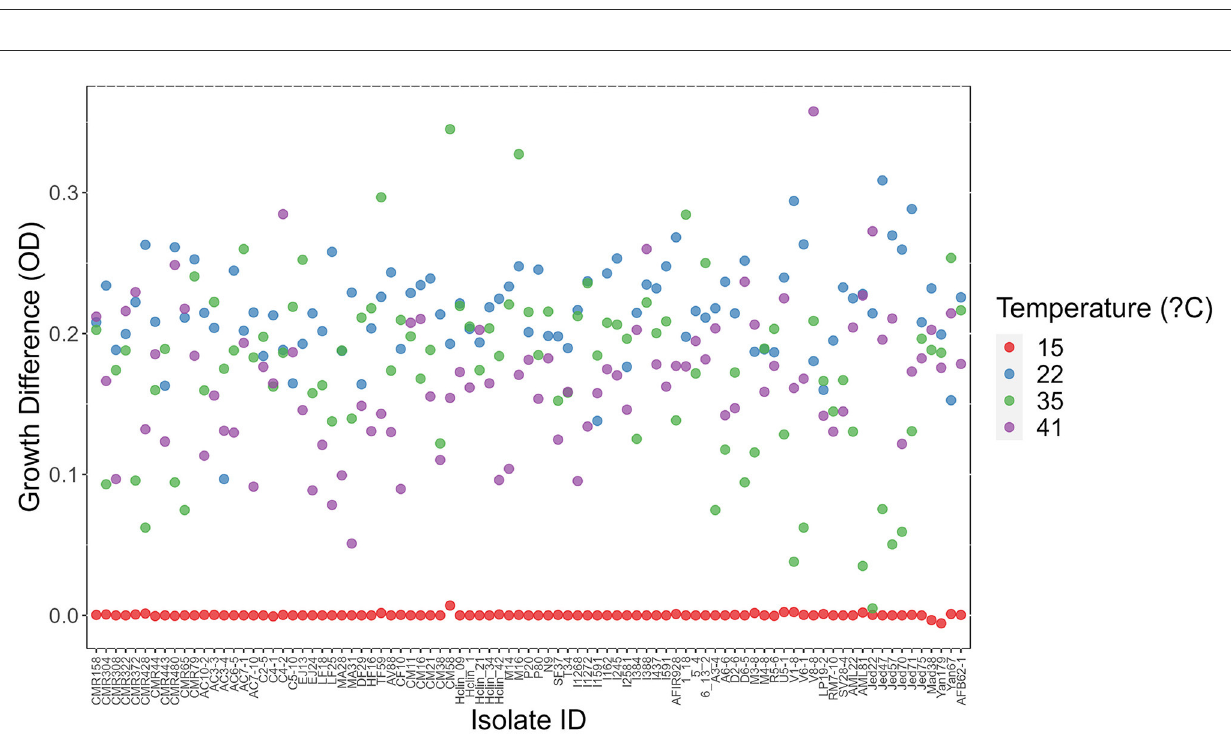
FIGURE4 Difference in growth between day 3 and day 1 at each of four temperatures among 89 A. fumigatus strains. X-axis represents strain names. Y-axis represents in OD value differences between day 3 and day 1.